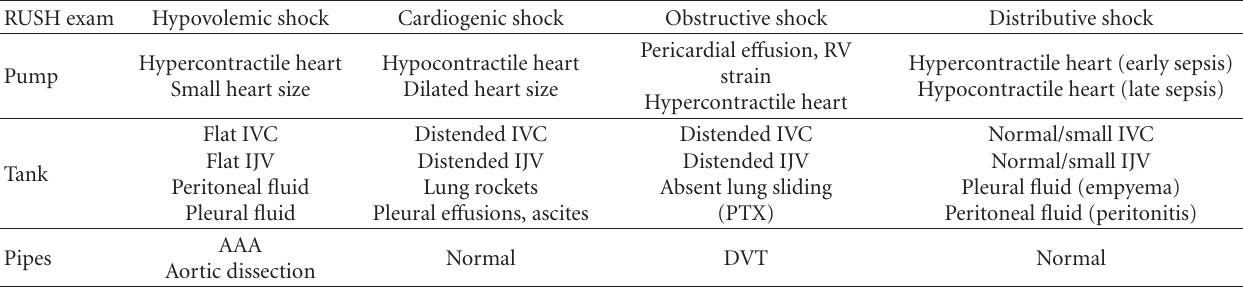
Table 1: RUSH protocol summary.